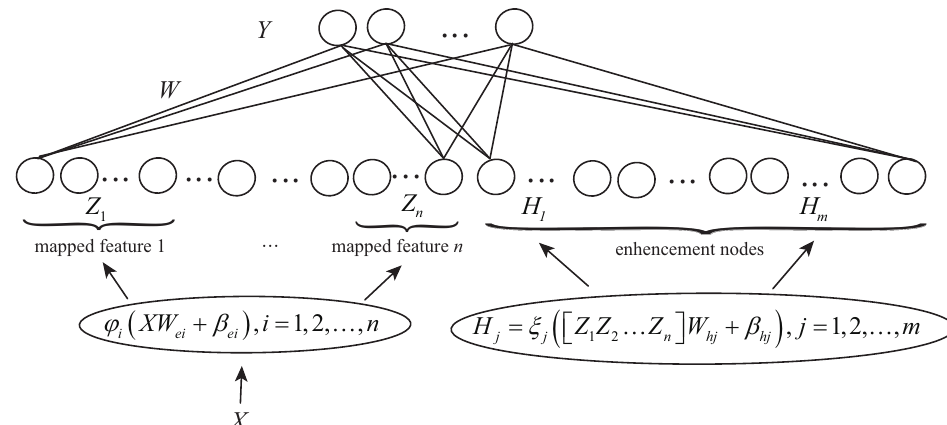
Figure 1. Structure of BNN